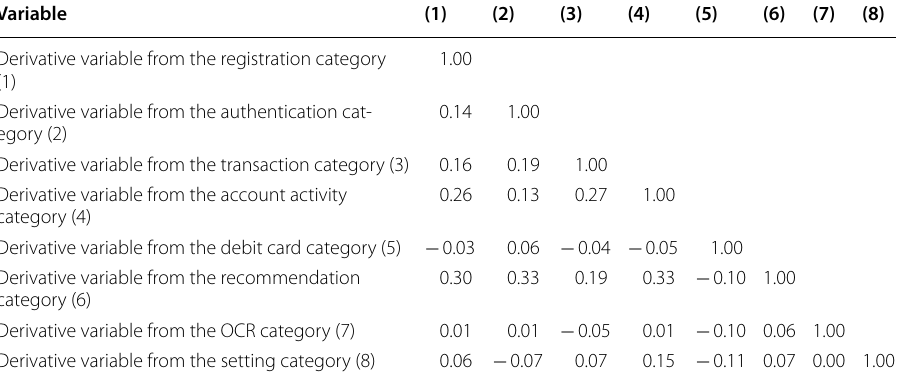
Table 4 Correlation coefficients among the derivative